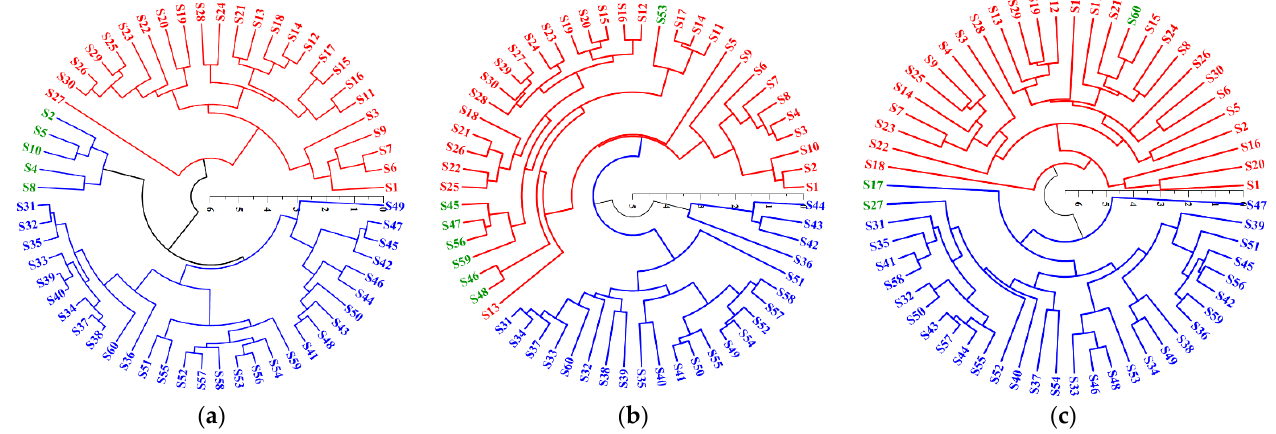
Figure 3 . Established HCA dendrograms of two origin samples with data acquired from the e-nose ( a ), e-tongue ( b ), and chemical analysis ( c ).